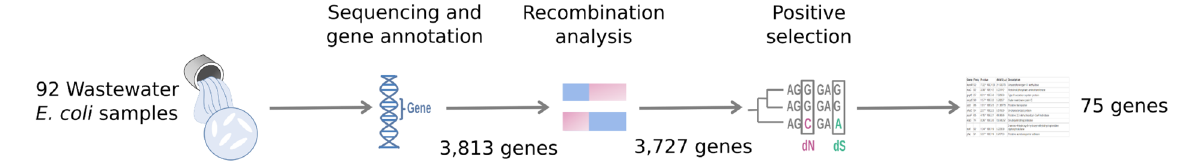
Figure 1. Overview of our study. We collected 92 E. coli genomes from a wastewater treatment plant in Dresden, Germany. We filtered genes under recombination and analyzed the remaining genes for positive